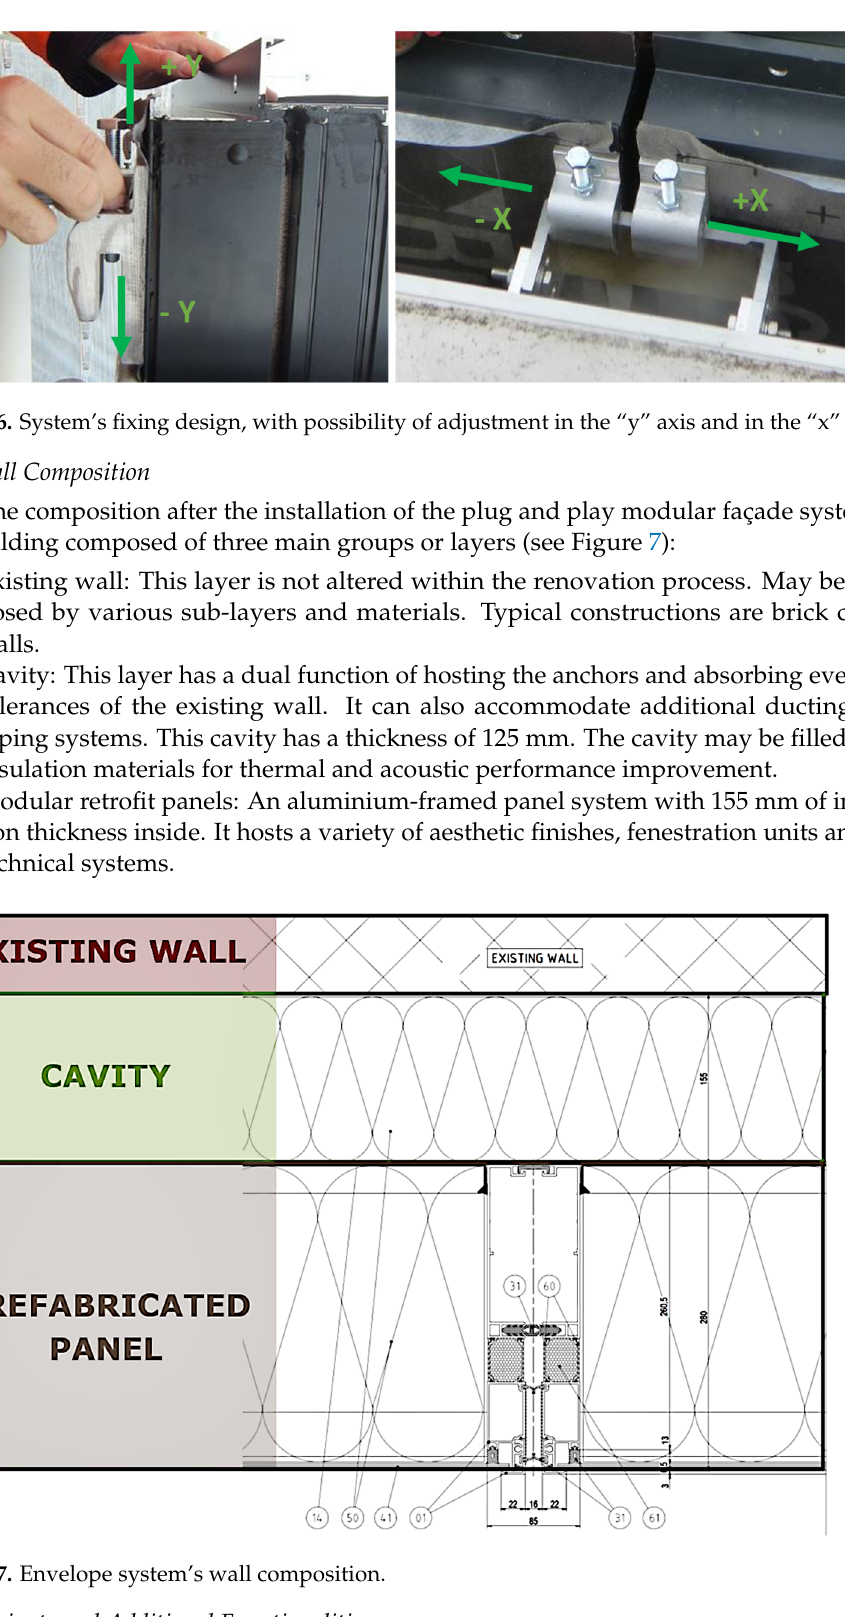
Figure 5. ( a ) Intermediate element for hanging panels and adjustment and leveling; ( b ) final detail of the joint between the slab and in plug and play modular system.